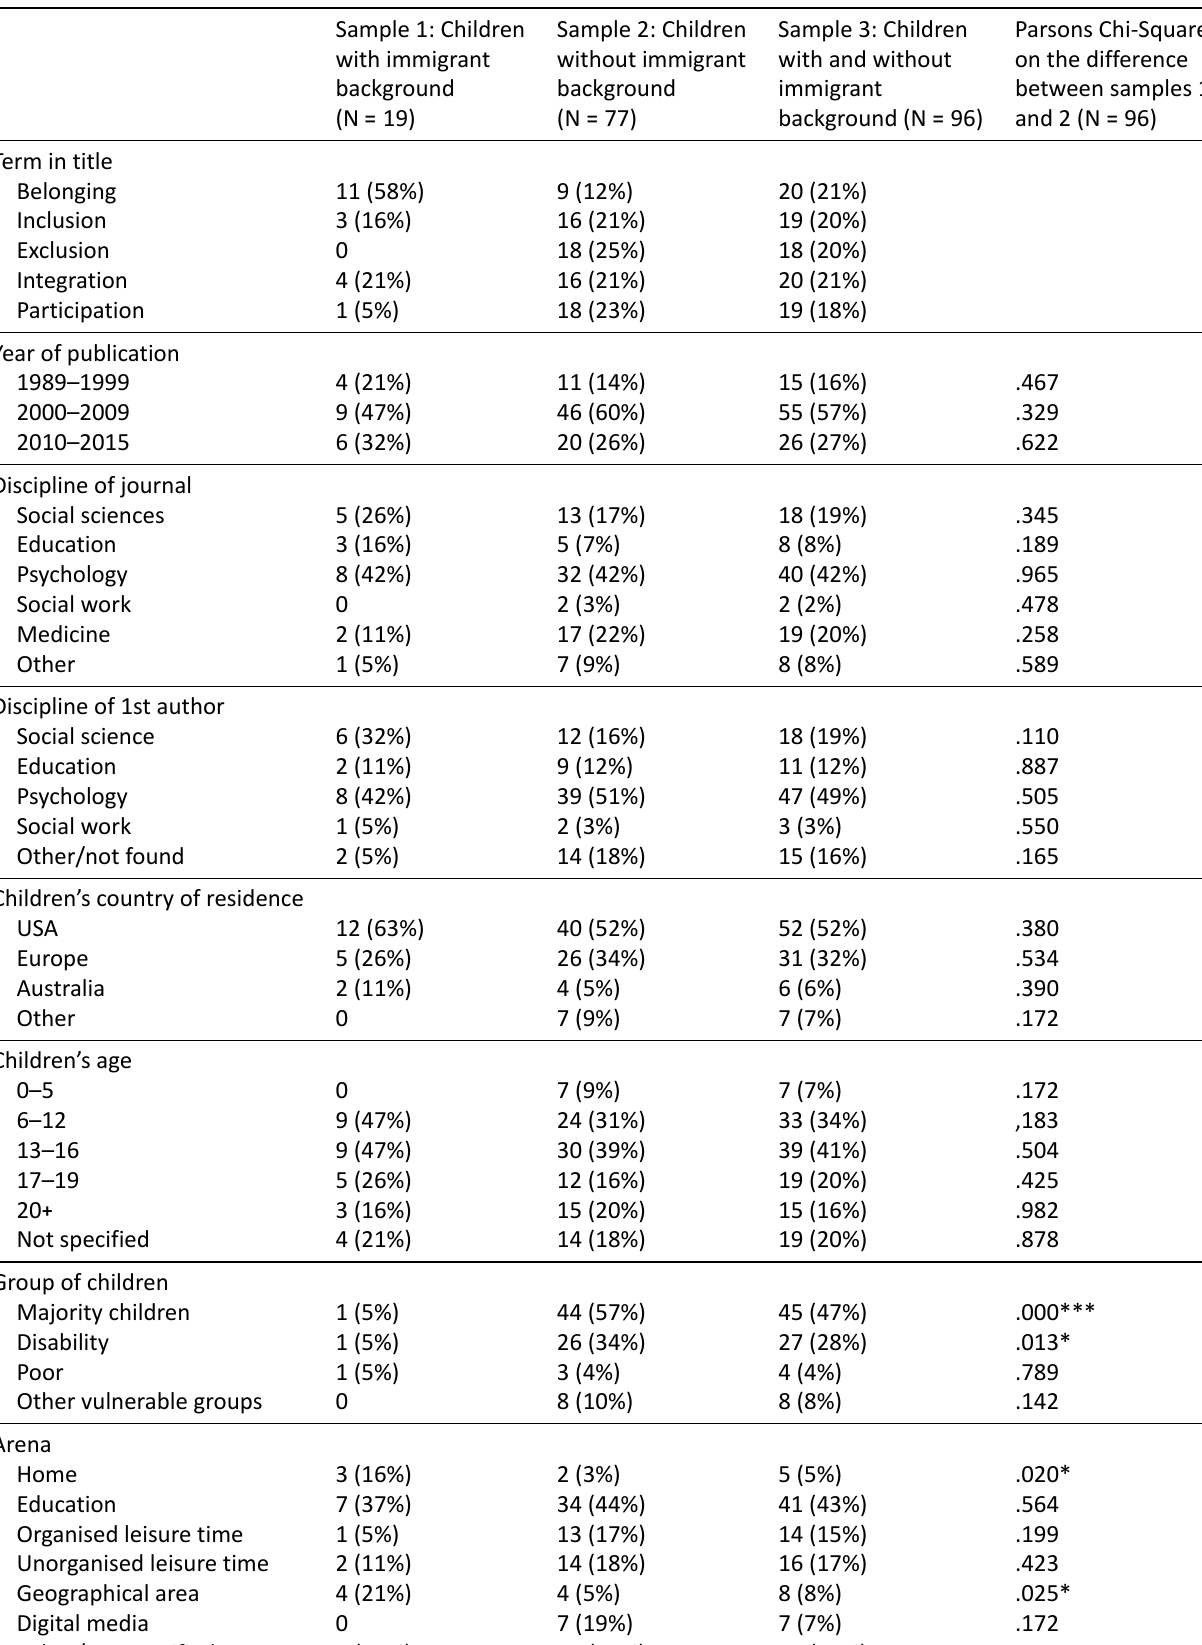
Table 3. Number of articles on children’s connections (samples 1, 2, and 3). Sample 1: Children Sample 2: